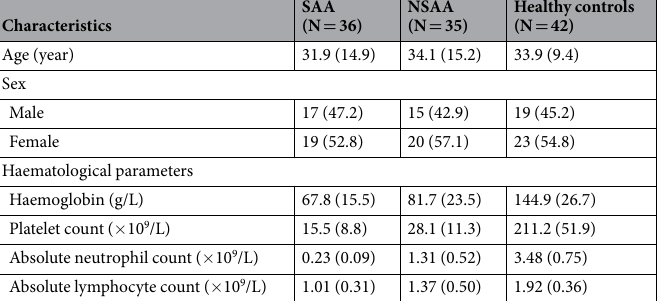
Table 1. Characteristics of the patients with aplastic anaemia and the healthy controls. Data are presented as mean (standard deviation) for most variables, although sex is presented as n (%). SAA: severe aplastic anaemia; NSAA: non-severe aplastic